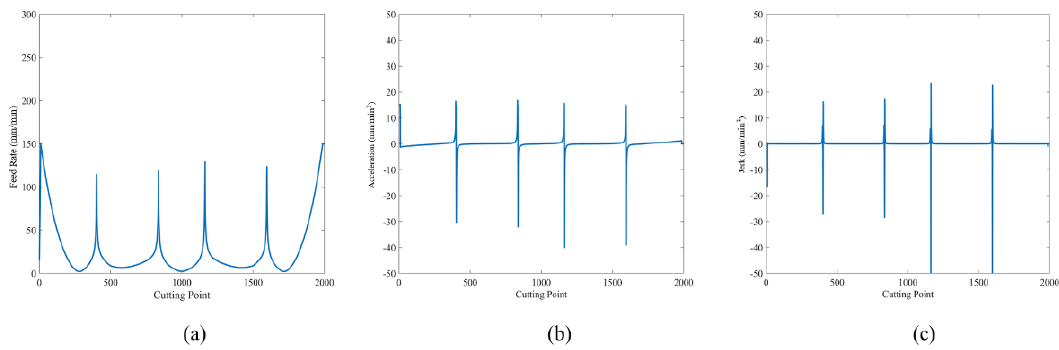
Figure 20. Cutting trident shape using method by Giannelli et al. [11]: ( a ) feed rate, ( b ) acceleration, and ( c ) jerk.